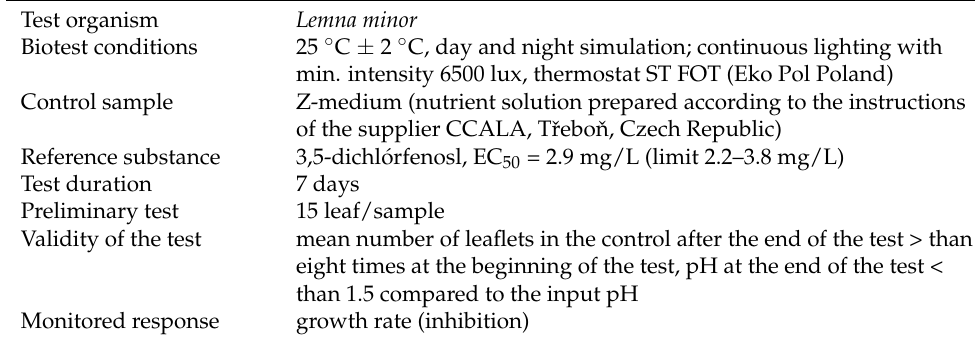
Table 2. The test conditions for Lemna minor